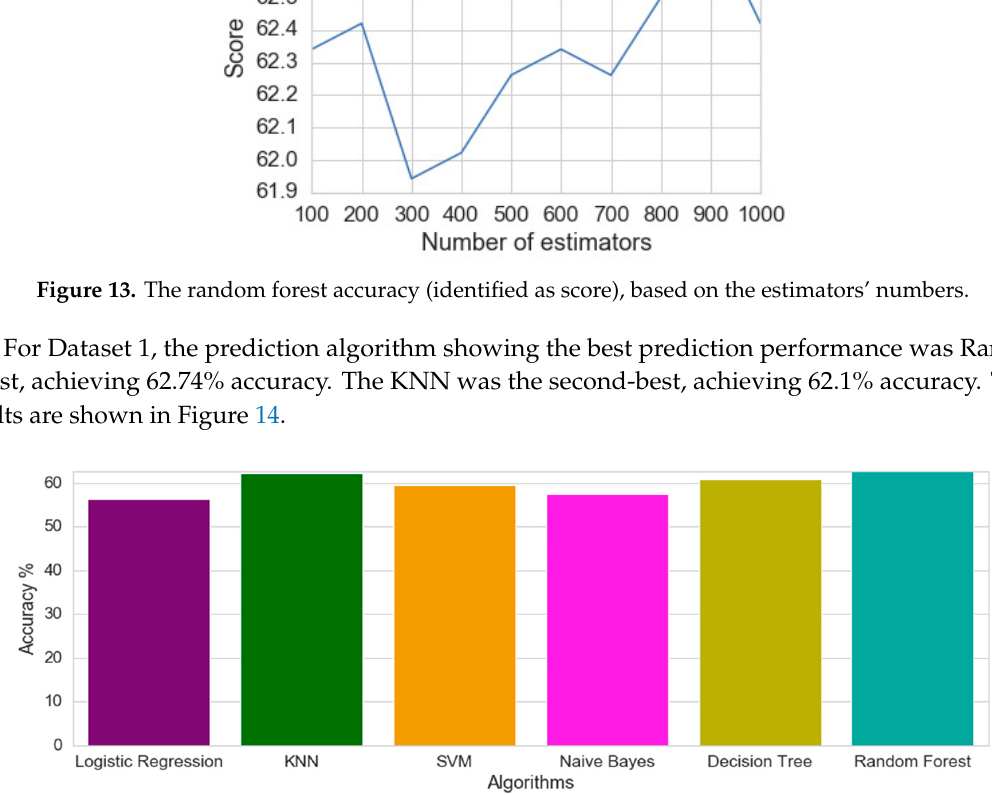
Figure 14. Algorithm accuracy comparison for Dataset 1 with four independent variables with high correlation.